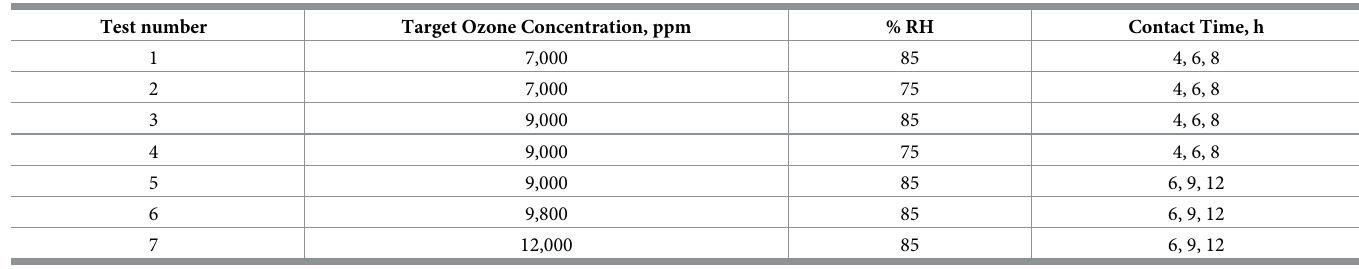
Table 2. Study test matrix. Test